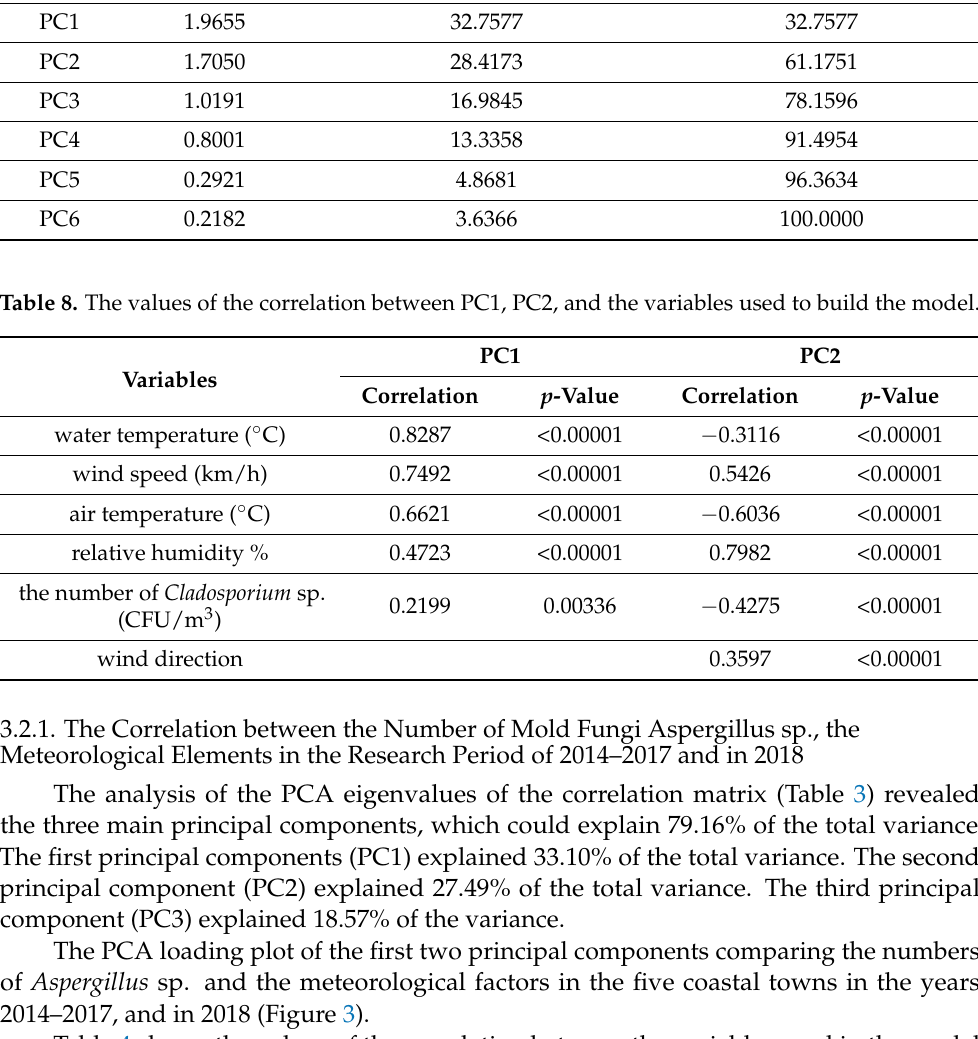
Table 7. Eigenvalues and values of the explained variance for the model from the Cladosporium sp. license. Explained Part of Multivariate Eigenvalue Variability of Accessions [%]